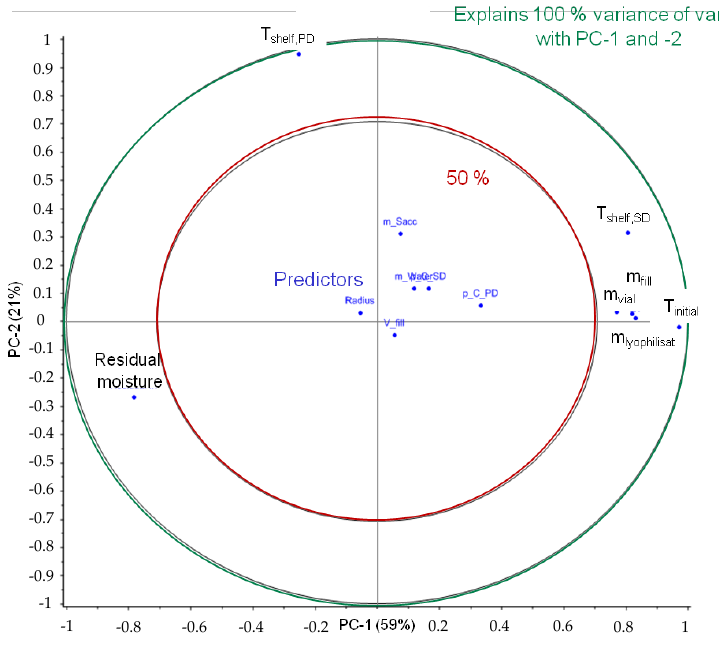
Figure 15. Correlation-Loading plot visualizing the dependencies between each variable as found for the Monte Carlo